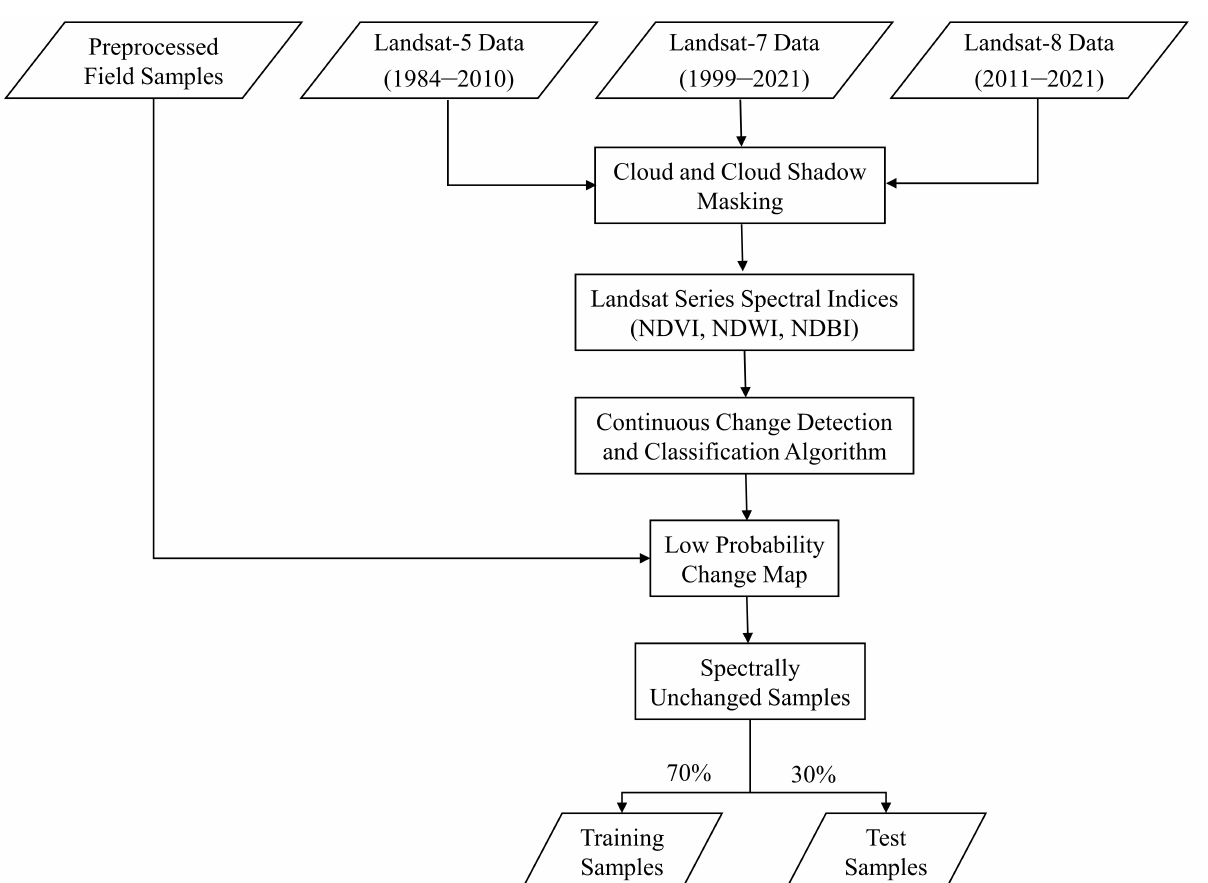
Figure 3. The Continuous Change Detection and Classification (CCDC) algorithm for selecting spectrally unchanged field samples over the past four decades from the study area (NDVI: Normal- ized Difference Vegetation Index, NDWI: Normalized Difference Water Index, NDBI: Normalized Difference Build-up